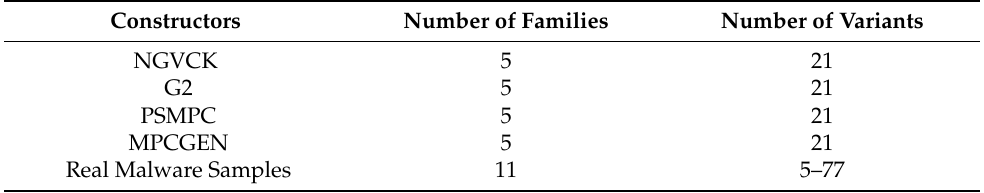
Table 7. Data set description with samples, number of families, and number of variants of each family.